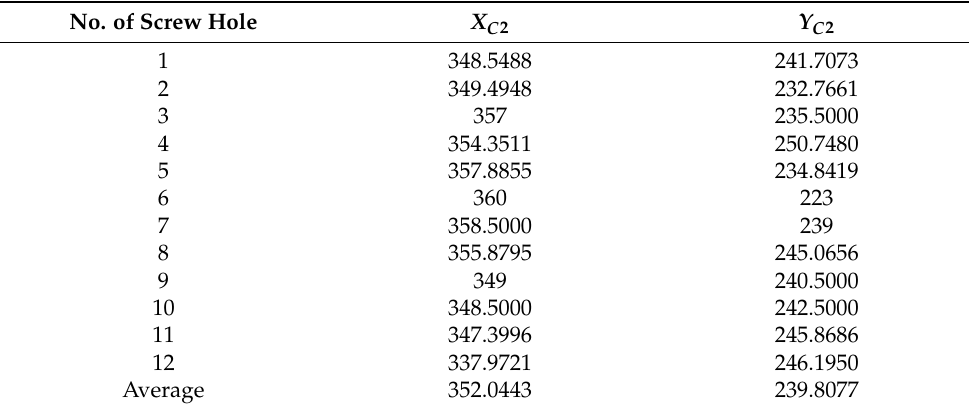
Table 3. Measurement data from 12 pictures taken by Camera 2.